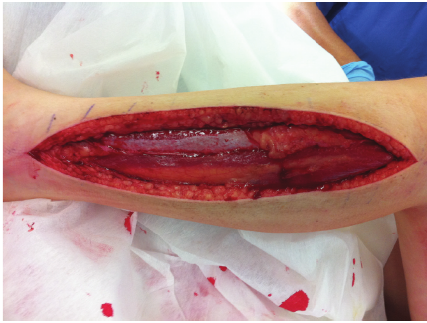
Figure 2: Lateral fasciotomy of left lower